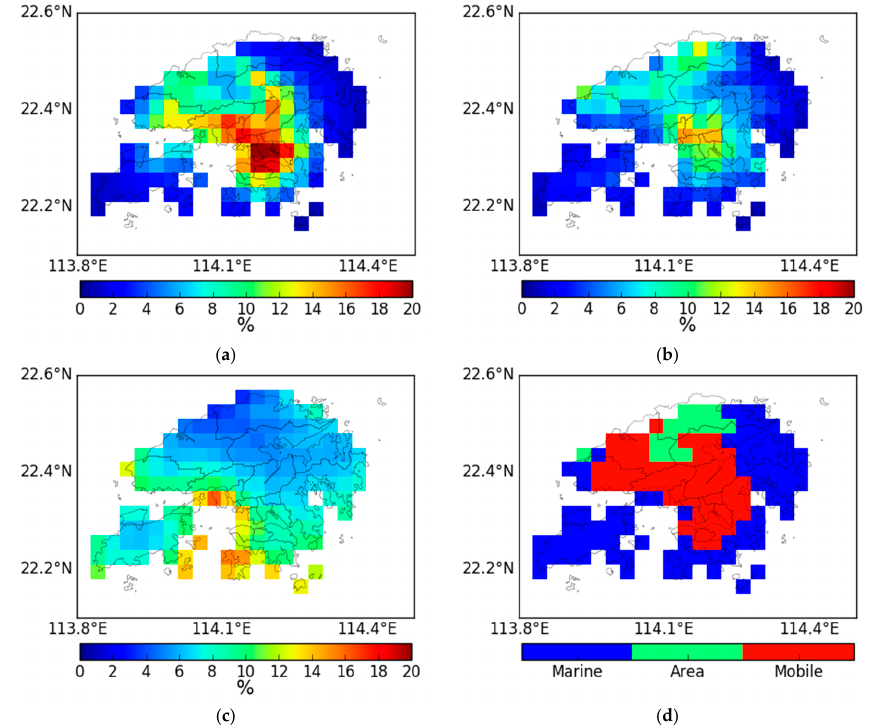
Figure 11. Contributions from local ( a ) mobile source, ( b ) area source and ( c ) marine source to PM 2.5 in different areas of Hong Kong at a resolution of 3 km. ( d ) Type of source with a maximal contribution in different areas of Hong Kong.